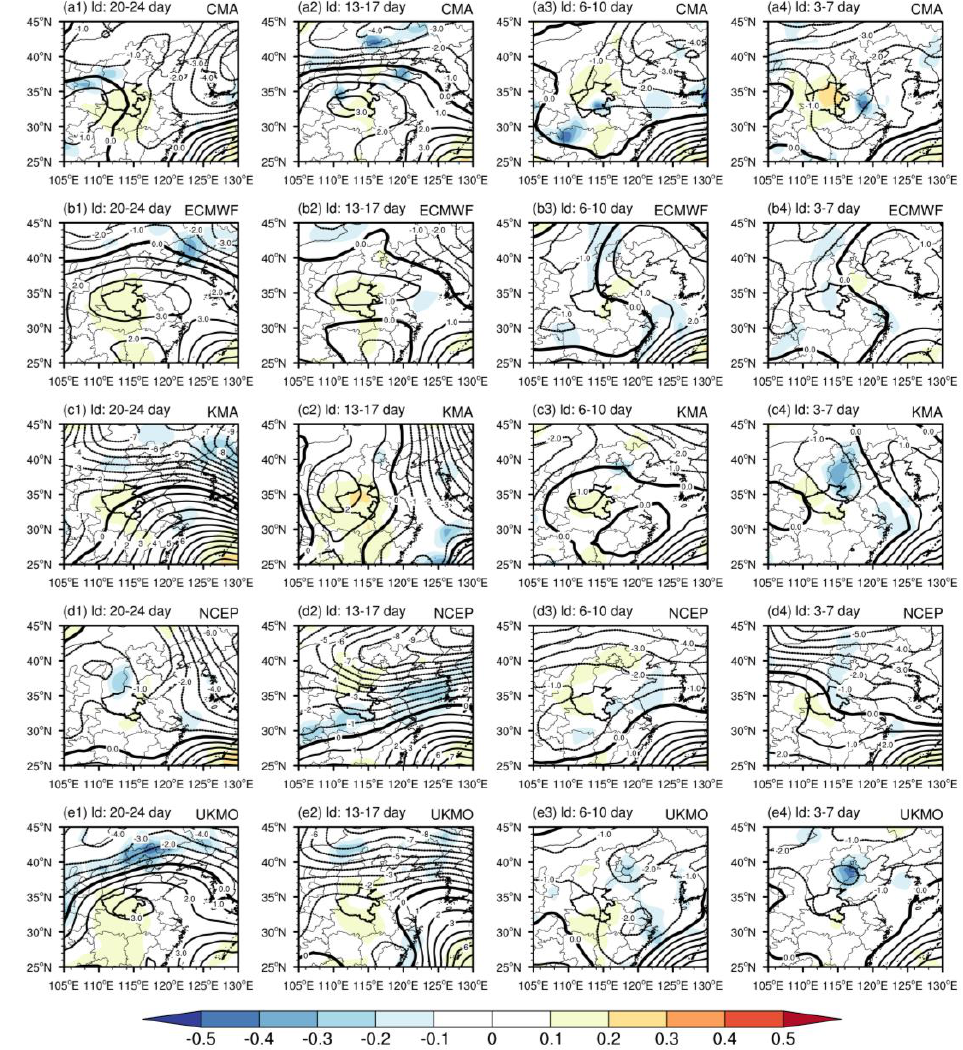
Figure 9. Spatial distribution of the difference in 500 hPa geopotential height (counter, m ) and vertical velocity (shading, p/s ) between model prediction and observation during 18 – 22 July in Henan Province.